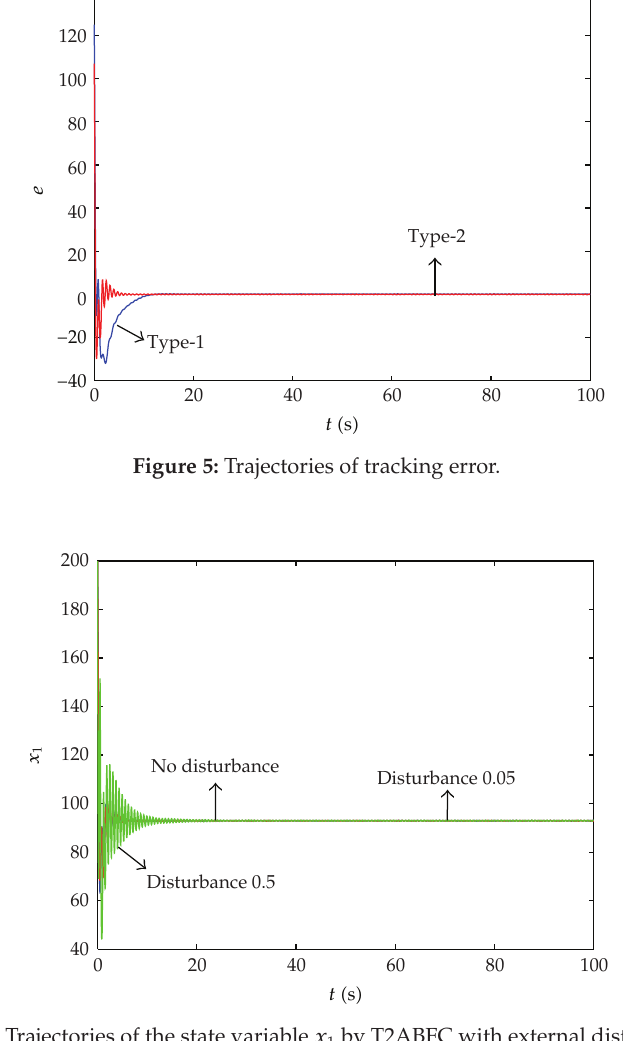
Figure 6: Trajectories of the state variable x 1 by T2ABFC with external